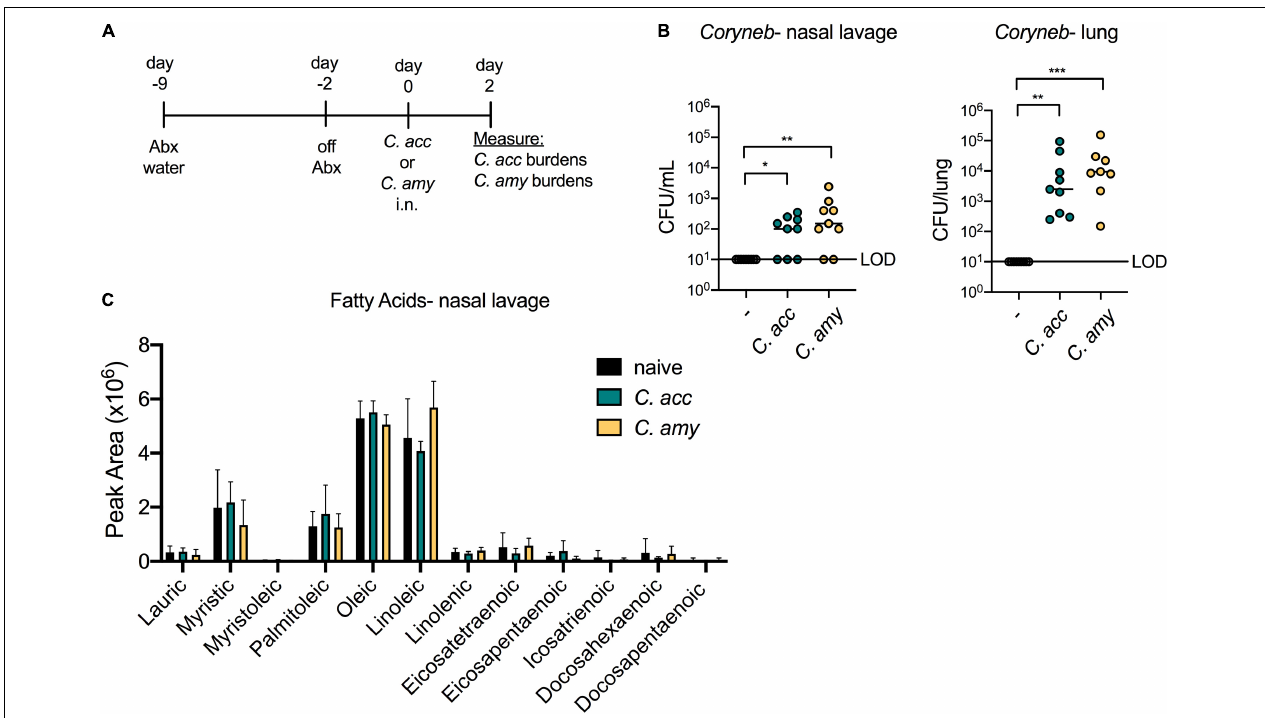
FIGURE 2 | Corynebacterium species colonize the upper and lower airway of antibiotic treated mice. Timeline for antibiotic treatment followed by infection with C. acc or C. amy (A) . Burden of Corynebacterium ( Coryneb ) in the nasal lavage fluid and lungs of mice 48 h post-infection with C. acc , C. amy , or PBS (–) detected by live growth (B) . Relative abundance of fatty acids detected in the nasal lavage fluid of naïve mice and mice 48 h post-infection with C. acc or C. amy (C) . Data are pooled from three independent experiments with 3–6 mice per group. No significant differences detected in relative FA abundances between groups, ANOVA. * p < 0.05, ** p < 0.01, *** p < 0.001, Kruskal-Wallis